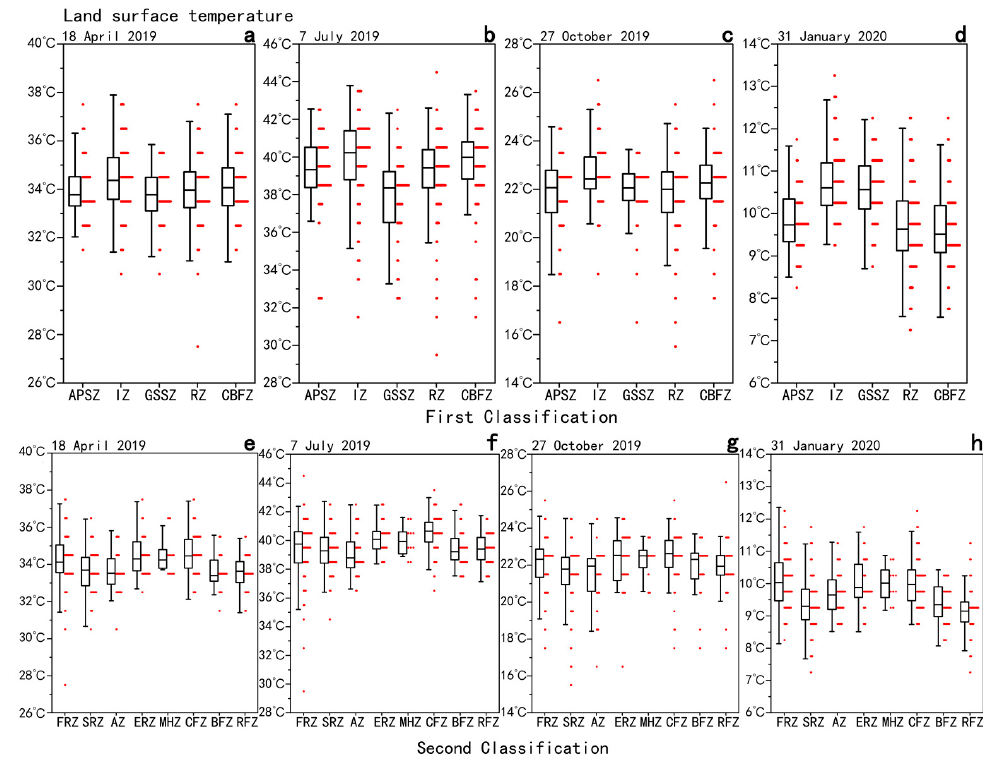
Figure 5. LST in different land use types: ( a – d ) statistics of LST for the first category of land use classification; ( e – h ) statistics of LST for the second category of land use classification.